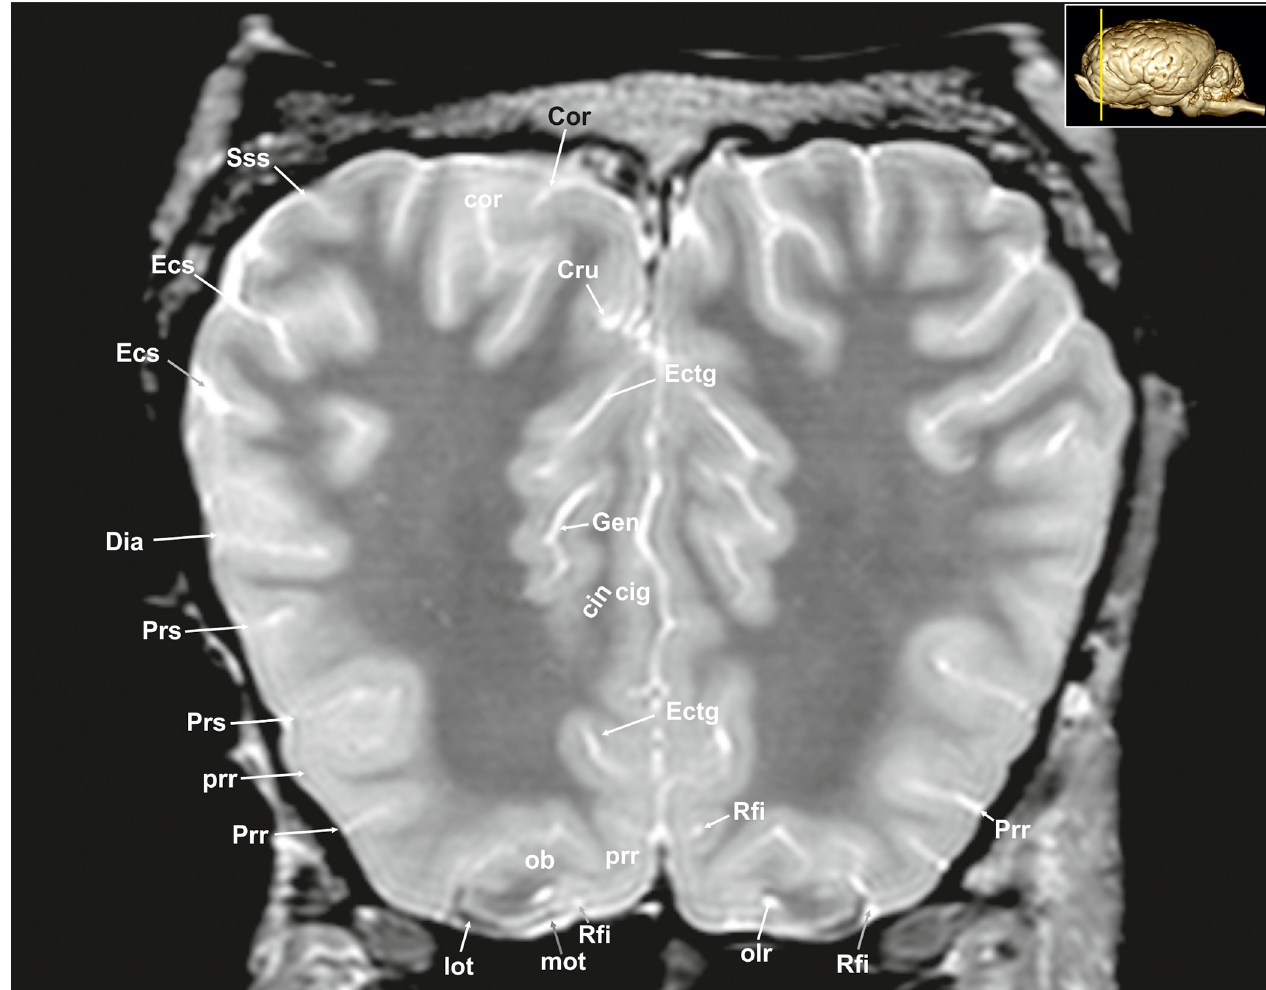
Fig 2. Transverse magnetic resonance image of the equine brain on the level of the olfactory peduncle. cin: cingulum, cig: cingulate gyrus, Cor: coronal sulcus, Cru: cruciate sulcus, Dia: diagonal sulcus, Ecs: ectosylvian sulcus, Ectg: ectogenual sulcus, Gen: genual sulcus, lot: lateral olfactory tract, mot: medial olfactory tract, olr: olfactory recess, Prr: prorean sulcus, prr: prorean gyrus, Prs: presylvian sulcus, Rfi: rhinal fissure, Sss: suprasylvian sulcus.